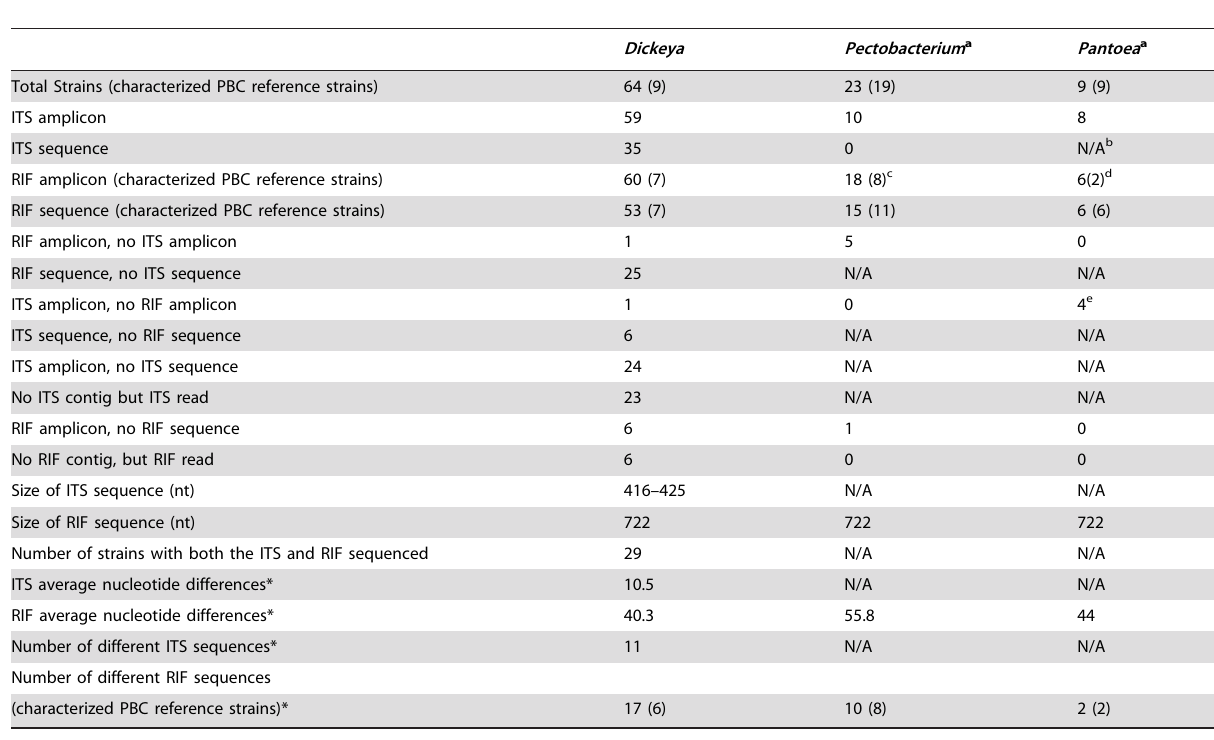
Table 6. Comparison of ITS and RIF markers for three genera of